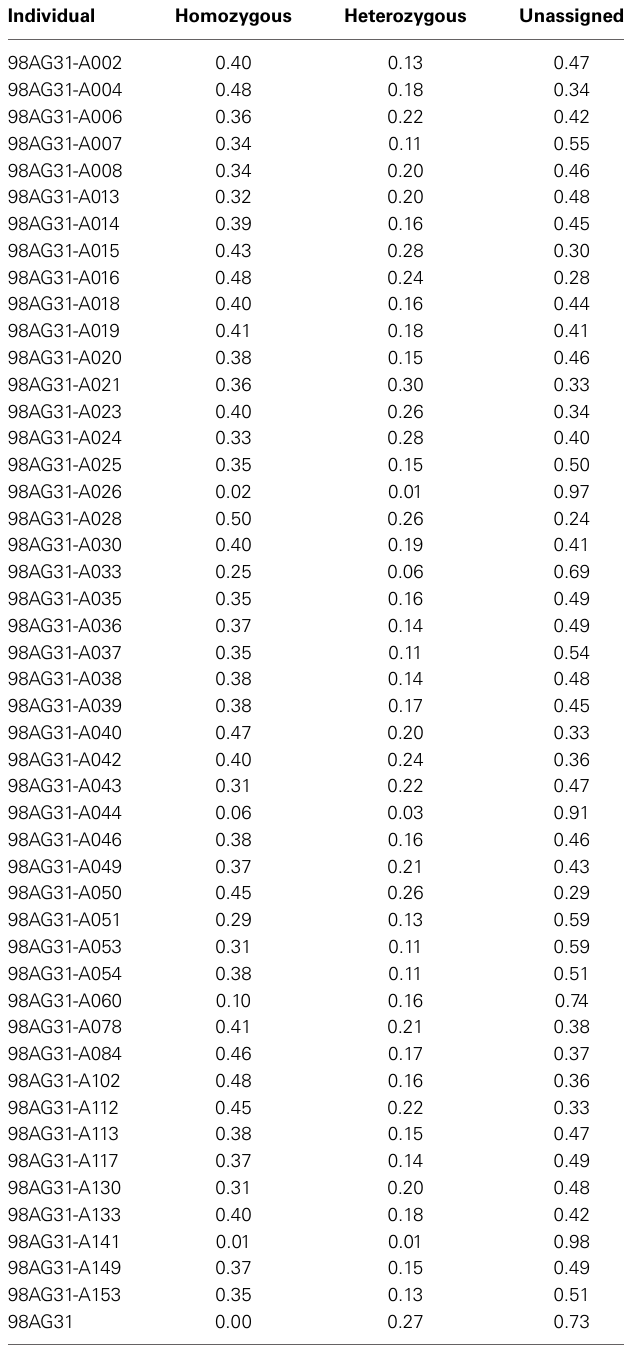
Table 3 | Proportion of recombination blocks determined as heterozygous, homozygous, or unassigned for all M. larici-populina individuals.